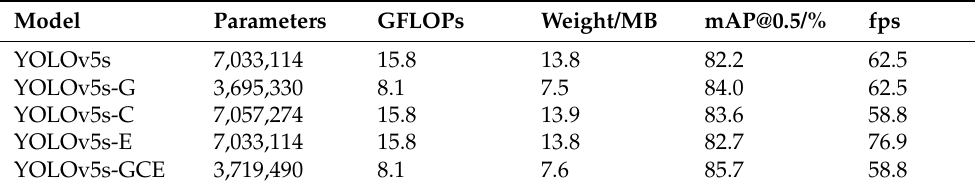
Table 1. Comparison of each model.